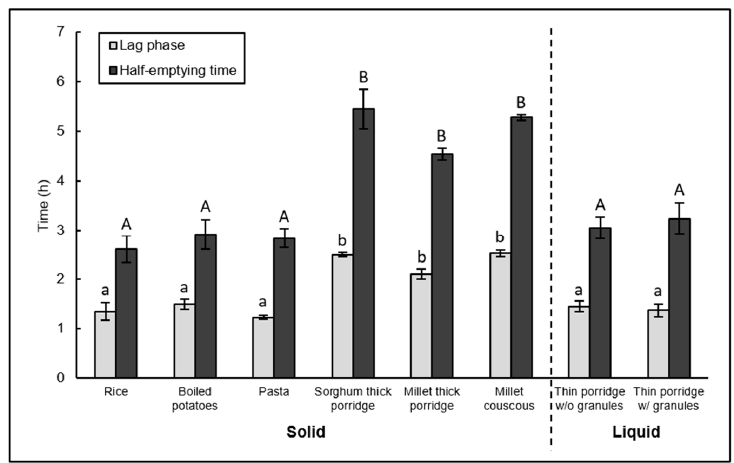
Figure 2. Gastric emptying parameters from the validation study, depicting correction for background differences in 13 C content of food sources. Mean values (error bars (SEM), n = 6) of lag phase and half-emptying time of the different solid and liquid test meals. Means not sharing the same letter are significantly different ( p < 0.05, statistical analysis was done separately for solid and liquid test meals). w/o = without, w/ =